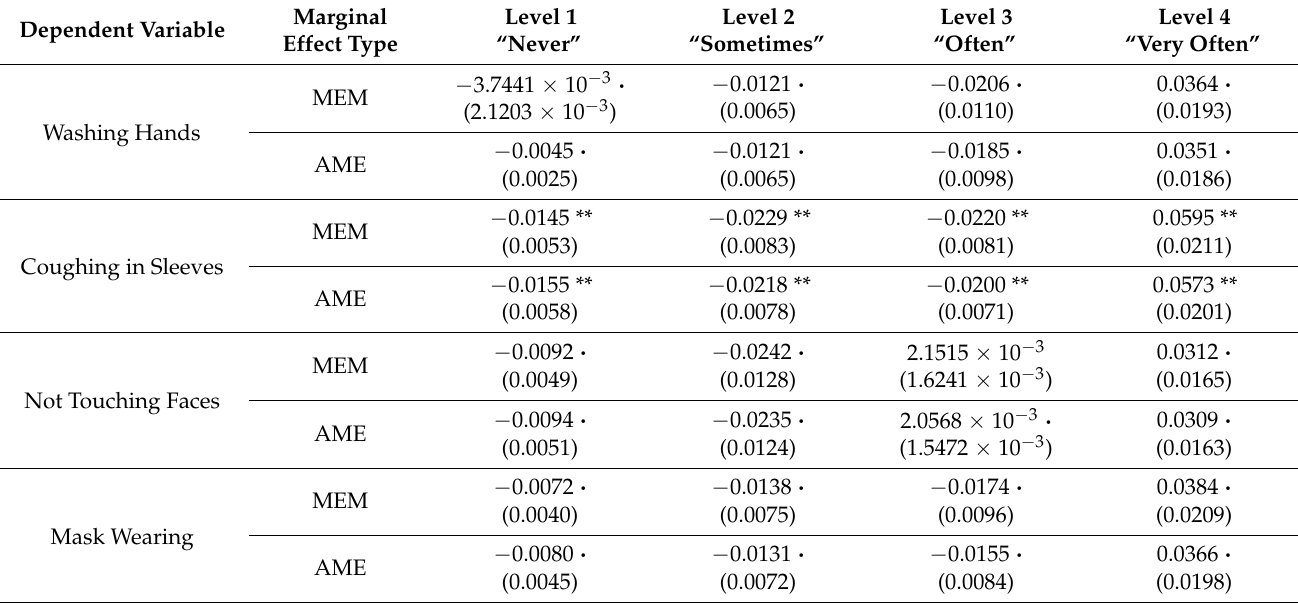
Table 8. Marginal effects of the MAAS scores on barrier gestures.